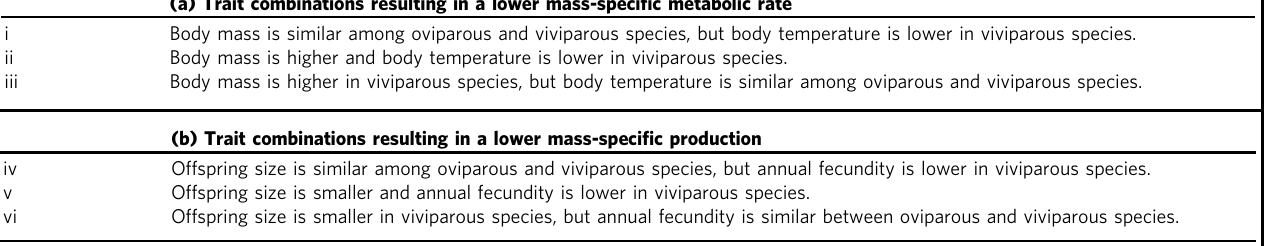
Table 1 Three trait combinations could explain the lower mass-speci fi c metabolic rate of viviparous species (a) and three other trait combinations could explain their lower mass-speci fi c production